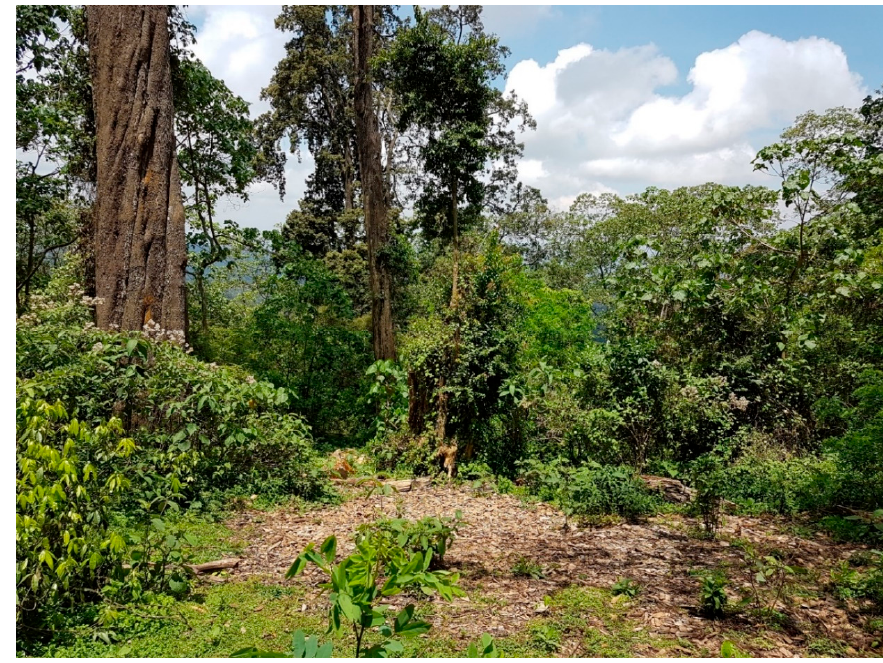
Figure 5. Understory vegetation in a forest SP. The understory vegetation that was not measured during the forest inventory could have influenced the image values and thus their relationship with AGB.